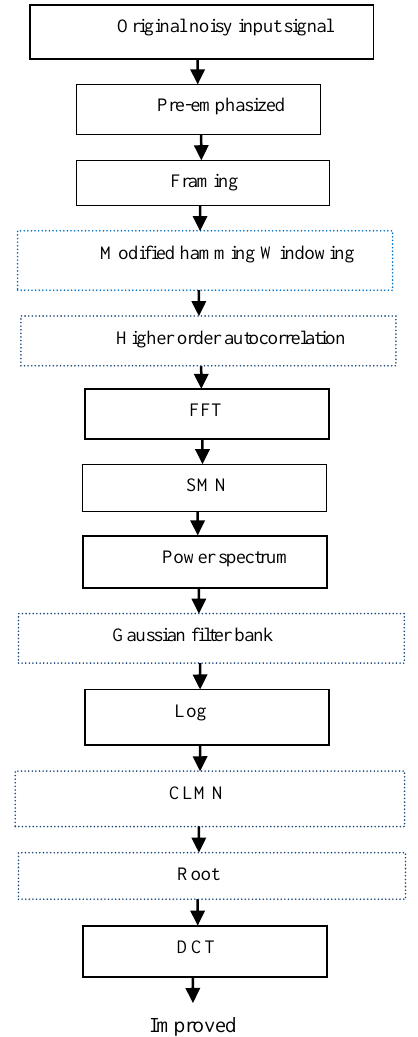
Figure 2. Proposed robust feature extraction algorithm